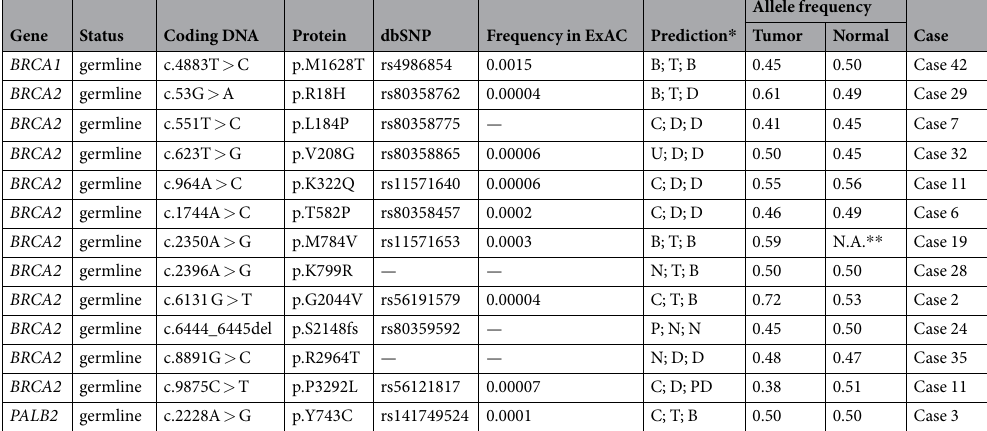
Table 1. Mutations in BRCA pathway genes in pancreatic ductal adenocarcinoma. * Predictions are noted in the order of ClinVar, SIFT and PolyPhen-2, and abbreviations are B, benign; C, conflicting interpretations of pathogenicity; D, damaging; N, no information; P, pathogenic; PD, possibly damaging; T, tolerant; and U, uncertain significance. ** N.A., not available because existence of this variation was confirmed by Sanger